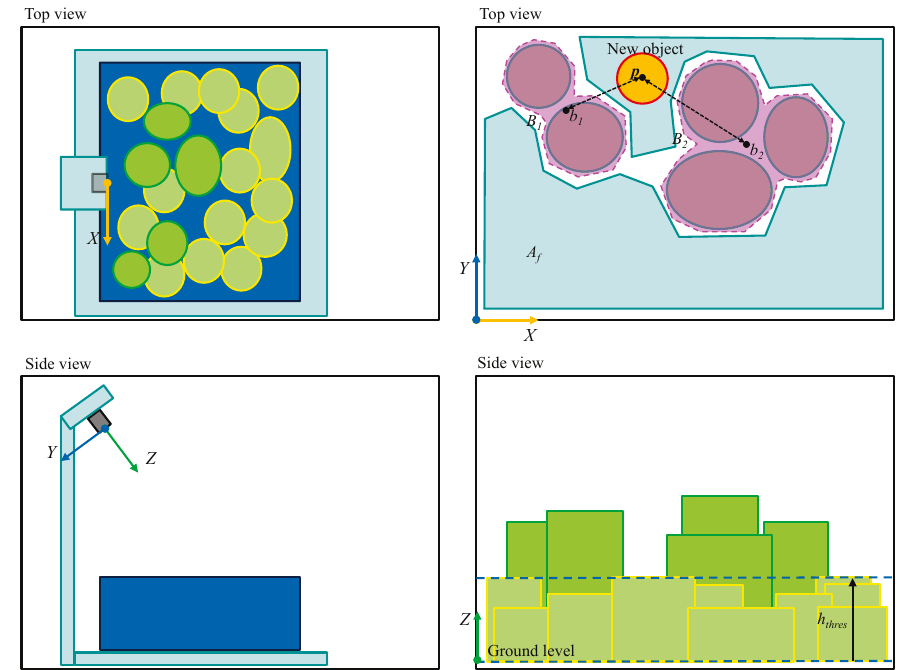
Figure 4. The illustration of the optimization